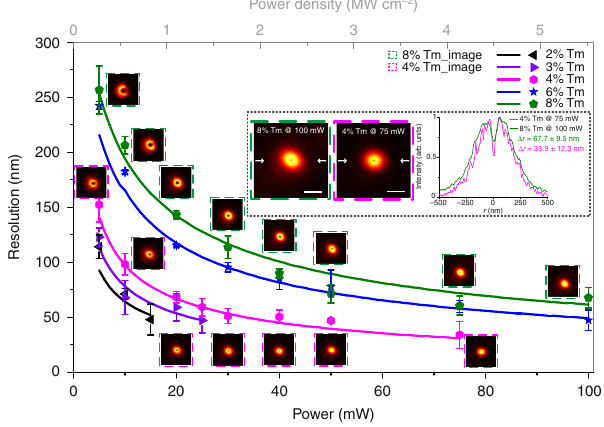
Fig. 3 Super-resolution scaling Δ r of UCNPs as a function of the excitation power (intensity). The dots of experimental data are fi tted well to the simulation results (solid lines; Supplementary Fig. 5). Error bars are de fi ned as s.d. from line pro fi les of several measurements. Insets, NIRES images of 8% Tm 3 + doped UCNPs at 5.5 MW cm − 2 (left), 4% Tm 3 + one at 4 MW cm − 2 (middle), and the corresponding cross section pro fi le lines (right). Pixel dwell time, 3 ms; pixel size, 10 nm. Scale bar is 500 nm. The series of NaYF 4 : 20% Yb 3 + , x % Tm 3 + UCNPs ( x = 2, 4, 6, and 8) ~40